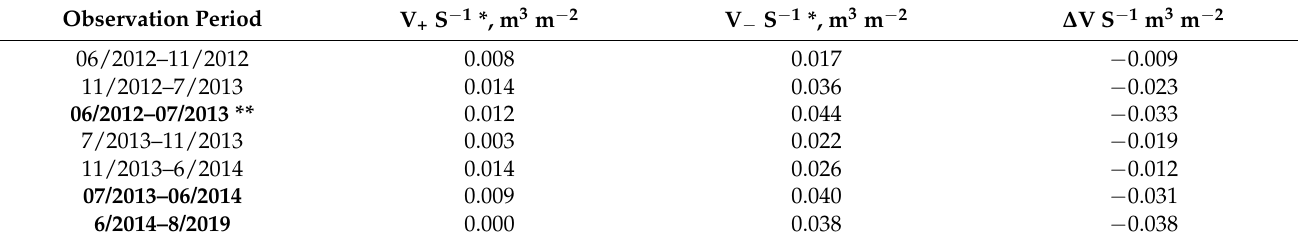
Table 6. Quantitative indicators characterizing the intensity of geomorphic processes at site 1 based on UAV survey results. Observation